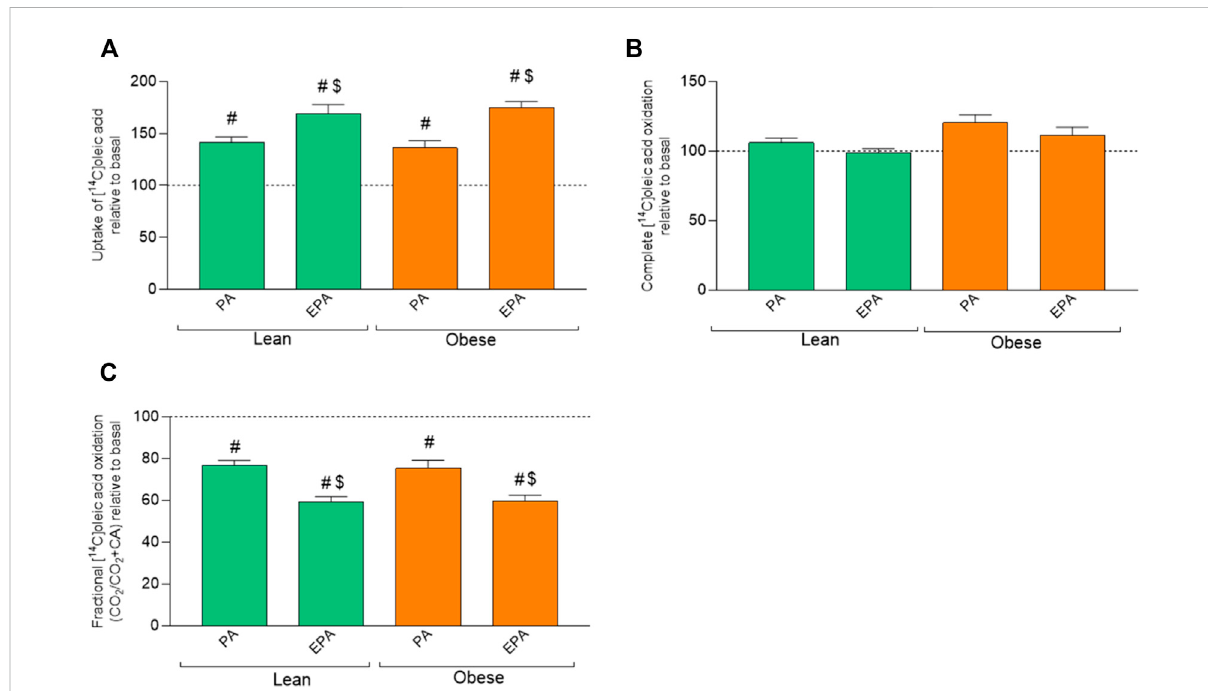
FIGURE 3 Effects of preincubationwith fatty acids on oleic acid uptake and oxidation. Differentiated skeletal muscle cells (myotubes) from lean ordonors with obesity were preincubated with either no fatty acid (basal), PA (100 µM) or EPA (100 µM) for 24 h, and then incubated with [1 − 14 C]oleic acid (100 µM) for 4 h. The fi gures show: (A) total uptake of OA in the cells (CO 2 +CA), (B) complete oxidation of OA to carbon dioxide (CO 2 ), (C) fractional OAoxidation(CO 2 /uptake).Resultspresentmean±SEM( n =8).Resultsforleangroup,basal(withouttreatment)wassetto100%,andforobese group, basal (without treatment) was set to 100%. Statistical signi fi cance was calculated as the difference between the two groups using one